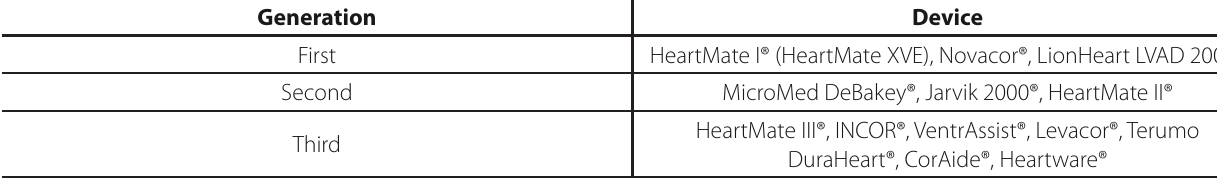
Table 2. Classification of long-term mechanical circulatory assist